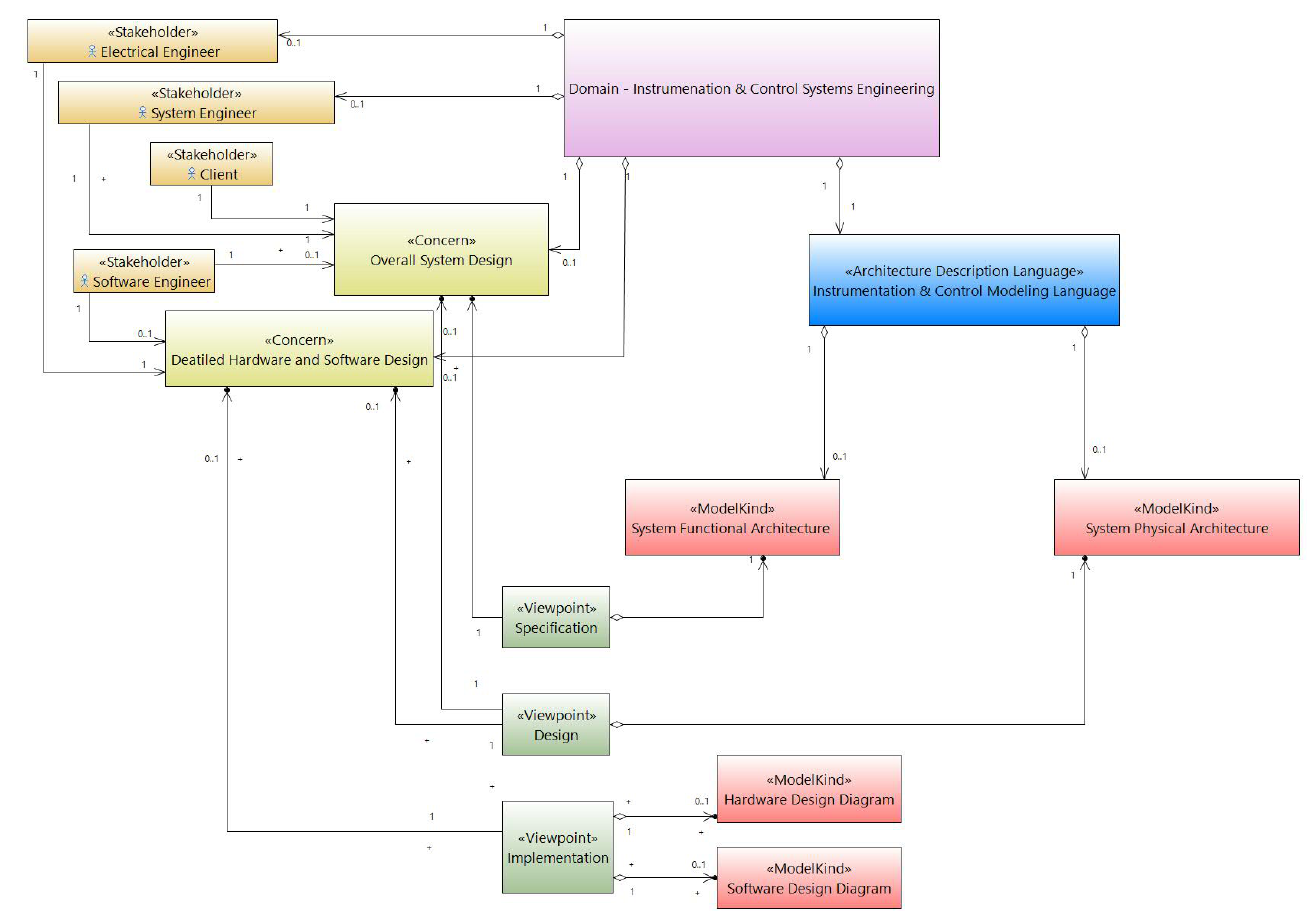
Figure 1. Class diagram of I&C systems Architectural